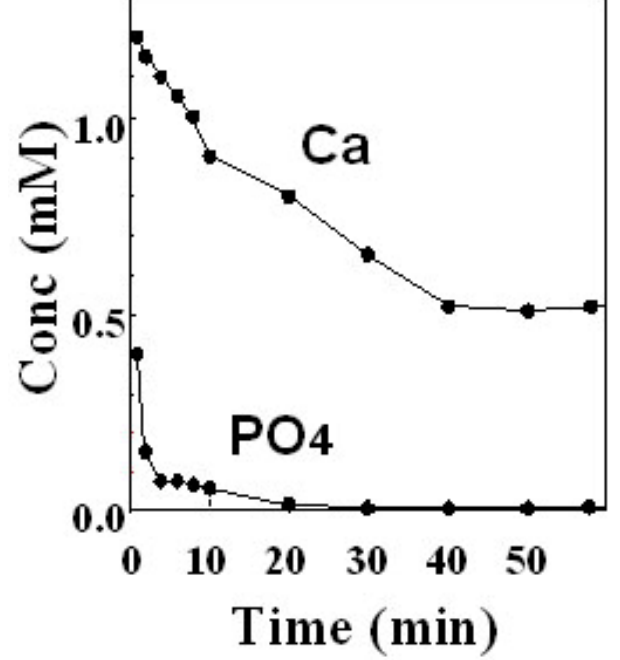
Figure 8. Example of the calcium and phosphate ions concentration in the suspension of apatite cement containing TTCP and DCPA. Calcium ion kept some concentration whereas phosphate concentration became less than detection limit over time